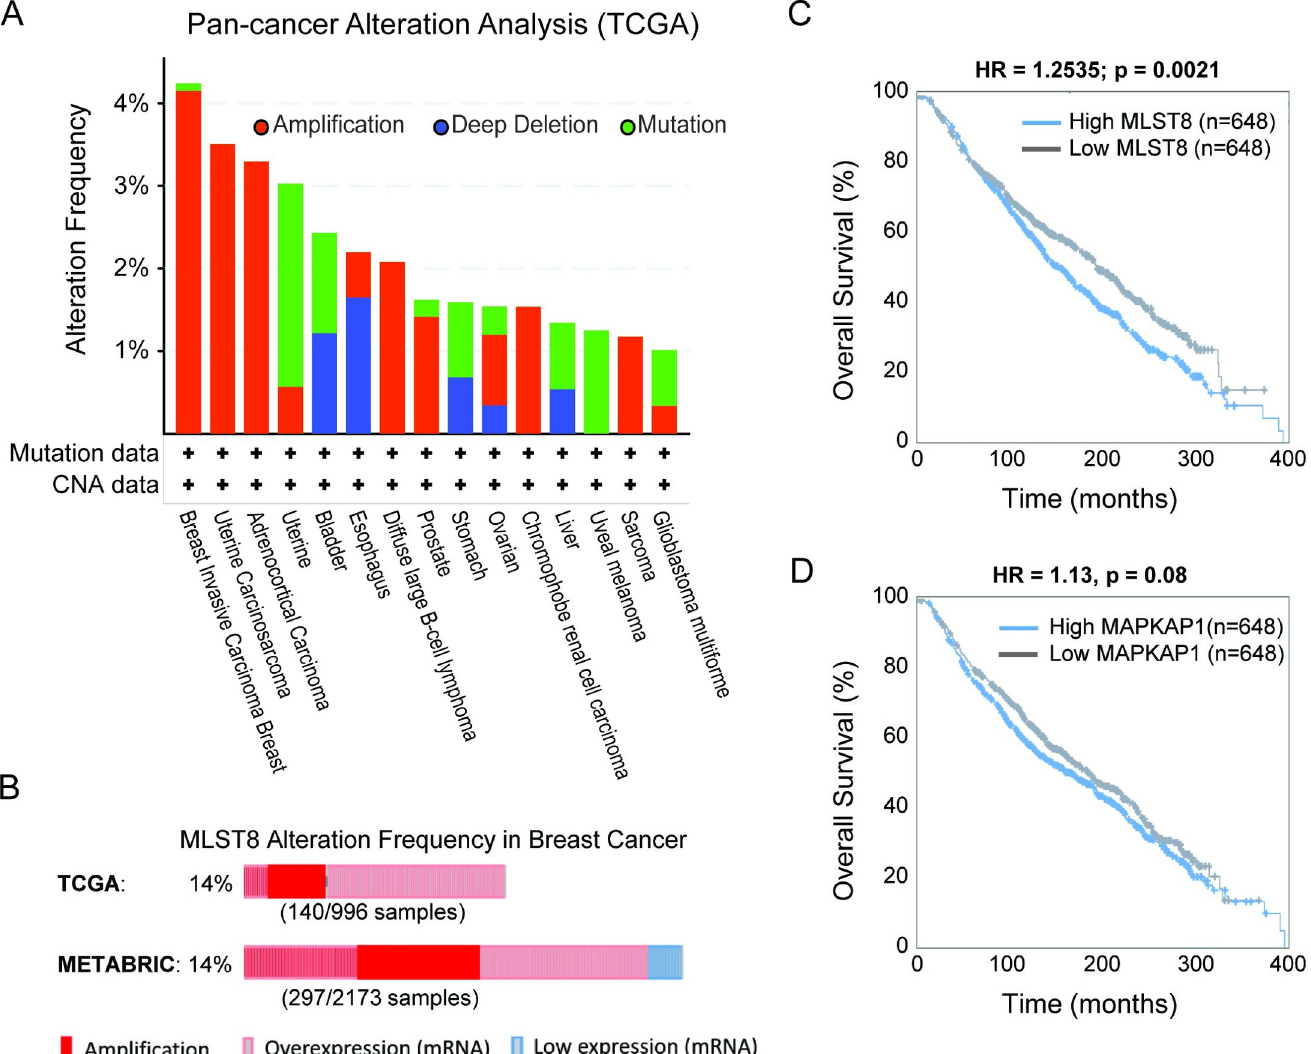
Fig 7. Interrogation of MLST8 alteration and prognostic value in cancer patients. (A) Alteration frequency of the MLST8 gene in cancer patients analyzed from TCGA database using cBioPortal (www.cbioportal.org), shown for the most frequently altered tumour types (cut-off > 1%). (B) Frequency of MLST8 alteration in breast cancer patients analyzed using two breast cancer cohorts TCGA and METABRIC. Only patients having MLST8 alterations are displayed for brevity. (C) Breast cancer patients with high MLST8 expression are significantly associated with poorer overall survival outcome compared to those with low MLST8 expression. (D) No significant differences in overall survival between patients having ‘low’ and ‘high’ expression of MAPKAP1, the gene encoding SIN1.